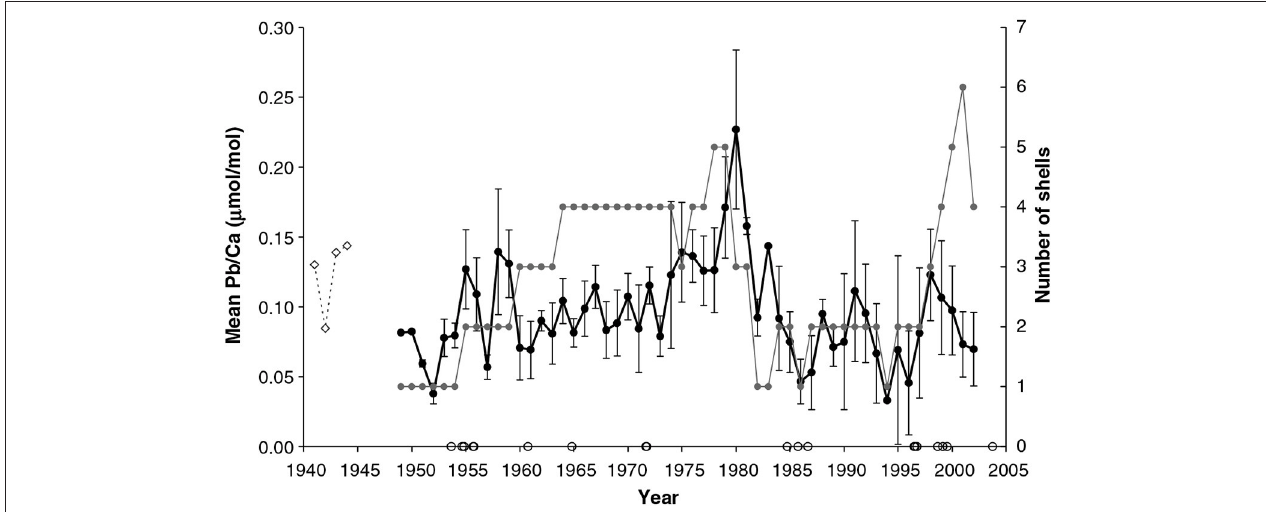
FIGURE 6 | Mean of annually sampled Pb/Ca ratios from 11 M. mercenaria shells. The gray line and symbols indicate the number of M. mercenaria shells each mean is based on and error bars representing standard errors. The open symbols on the x-axis represent hurricane years (data from NCSCO, 2004). For comparison, a fossil Pliocene shell (P1) is shown (dashed line, arbitrarily positioned at 1941–1944 (Figure from Gillikin et al., 2005b).